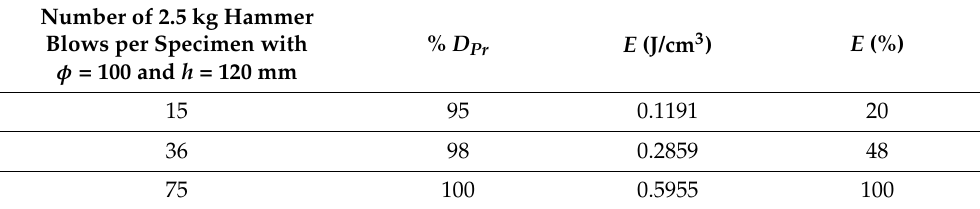
Table 1. Energy used to obtain the assumed compaction ratio of the specimens. Number of 2.5 kg